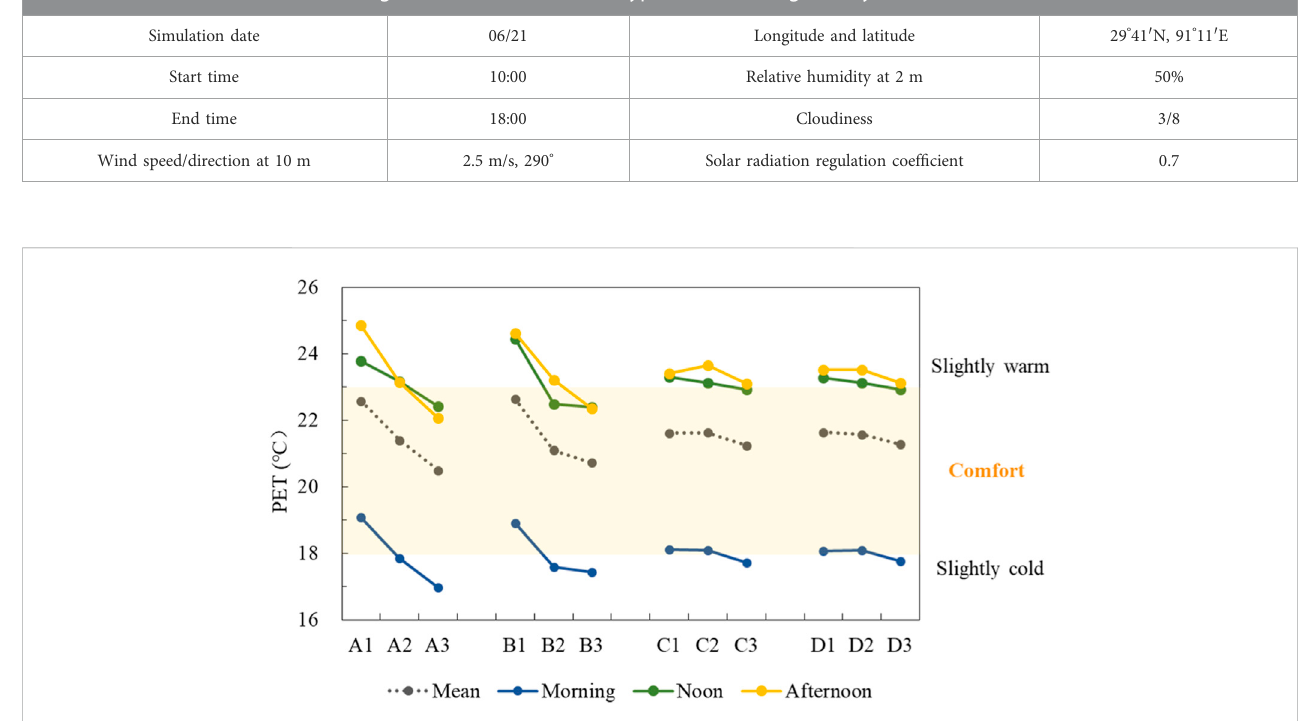
FIGURE 6 PET trend of outdoor public activities in residential areas in